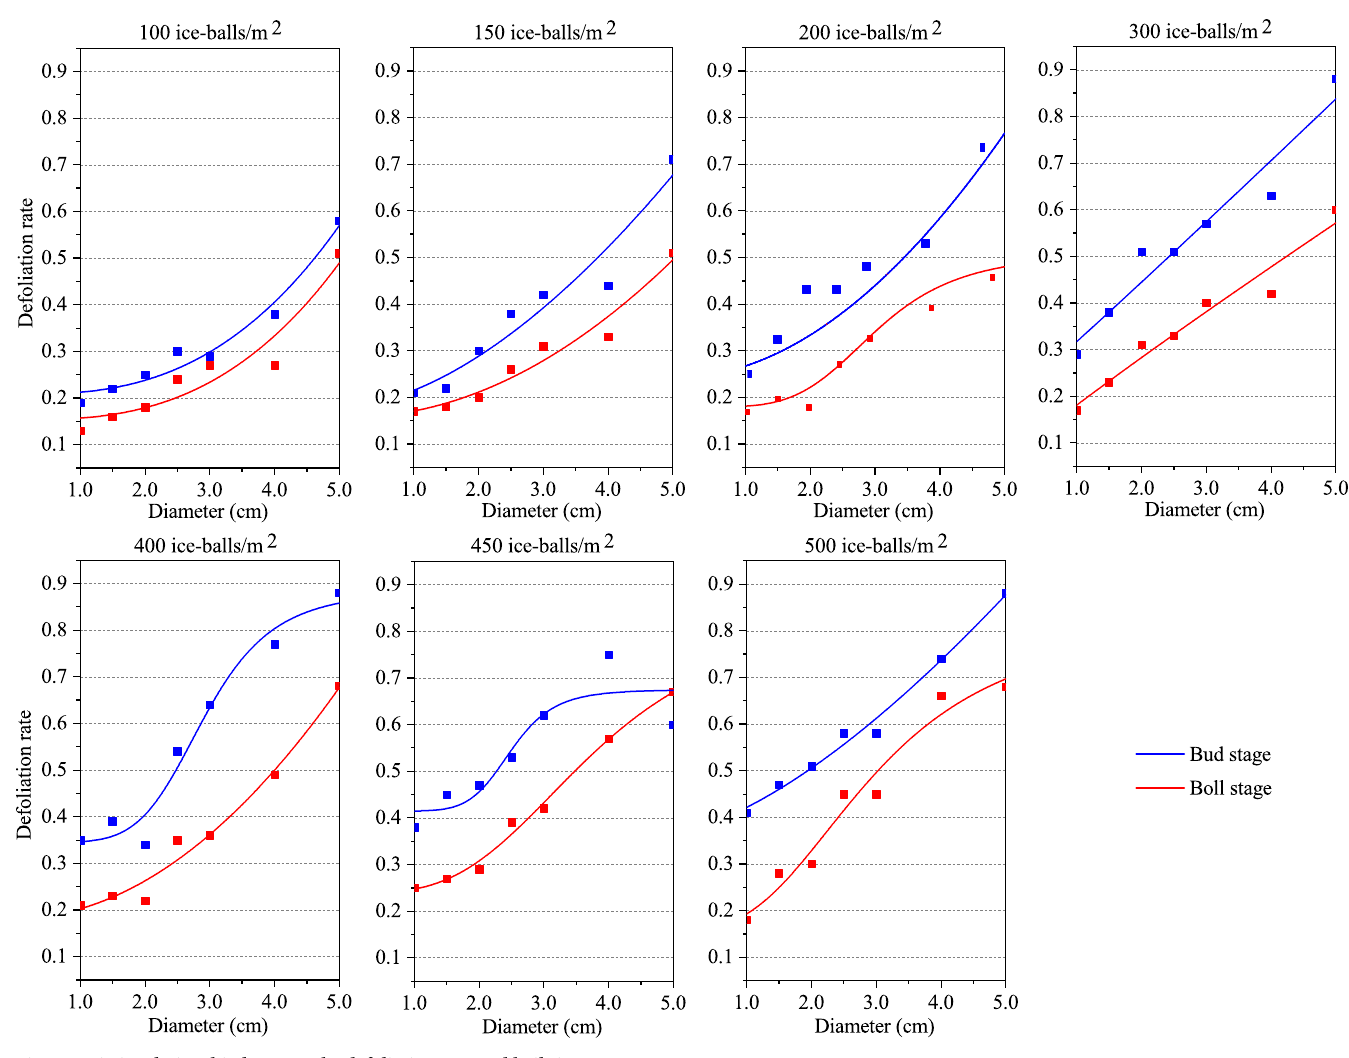
Fig 1. Logistic relationship between the defoliation rate and hail